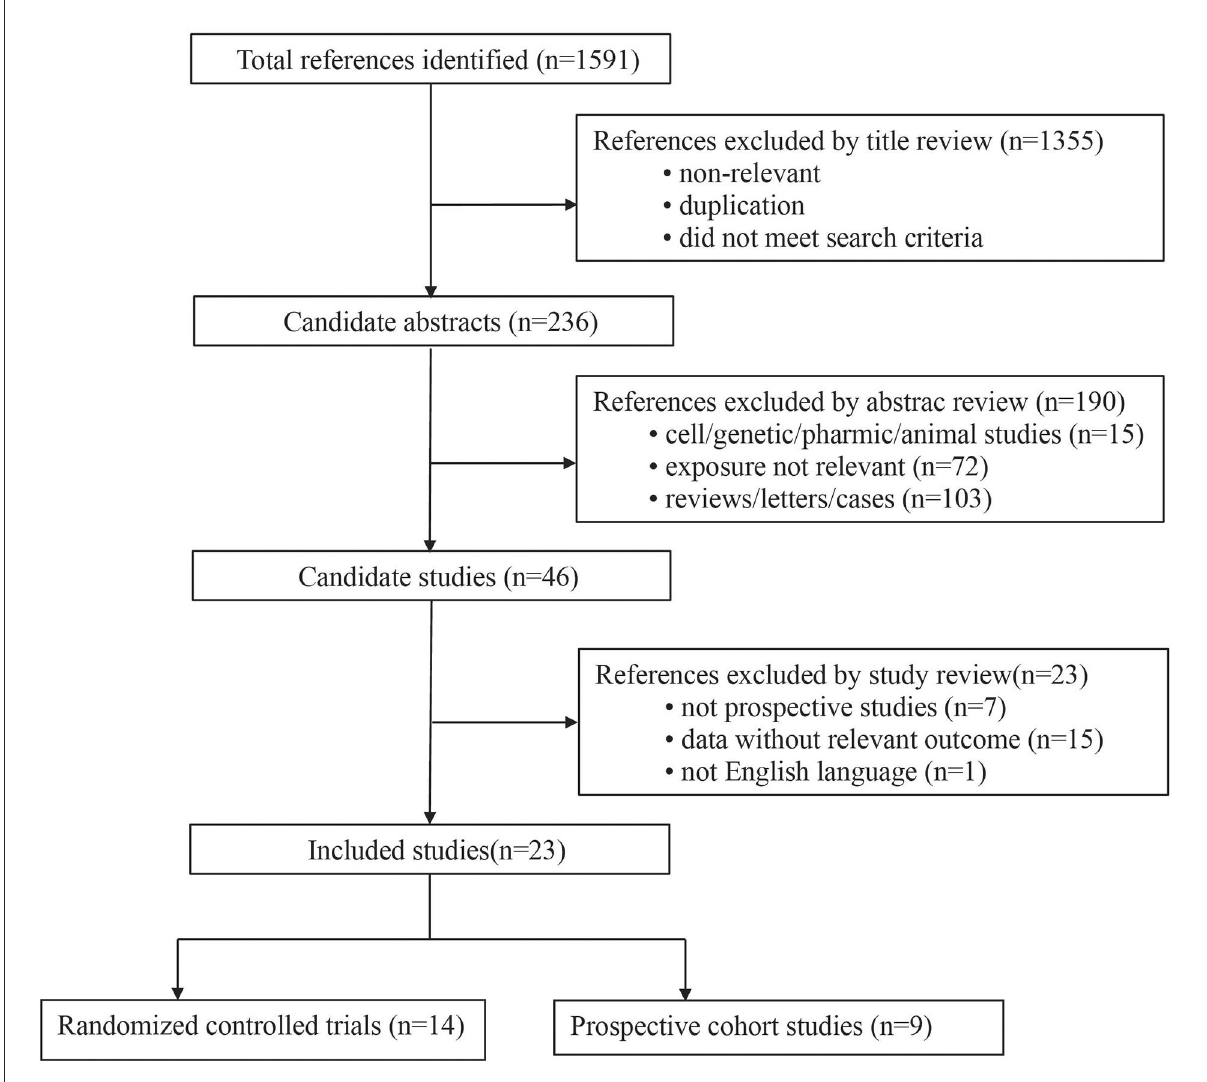
FIGURE1 Flow chart of records retrieved, screened, and included in this